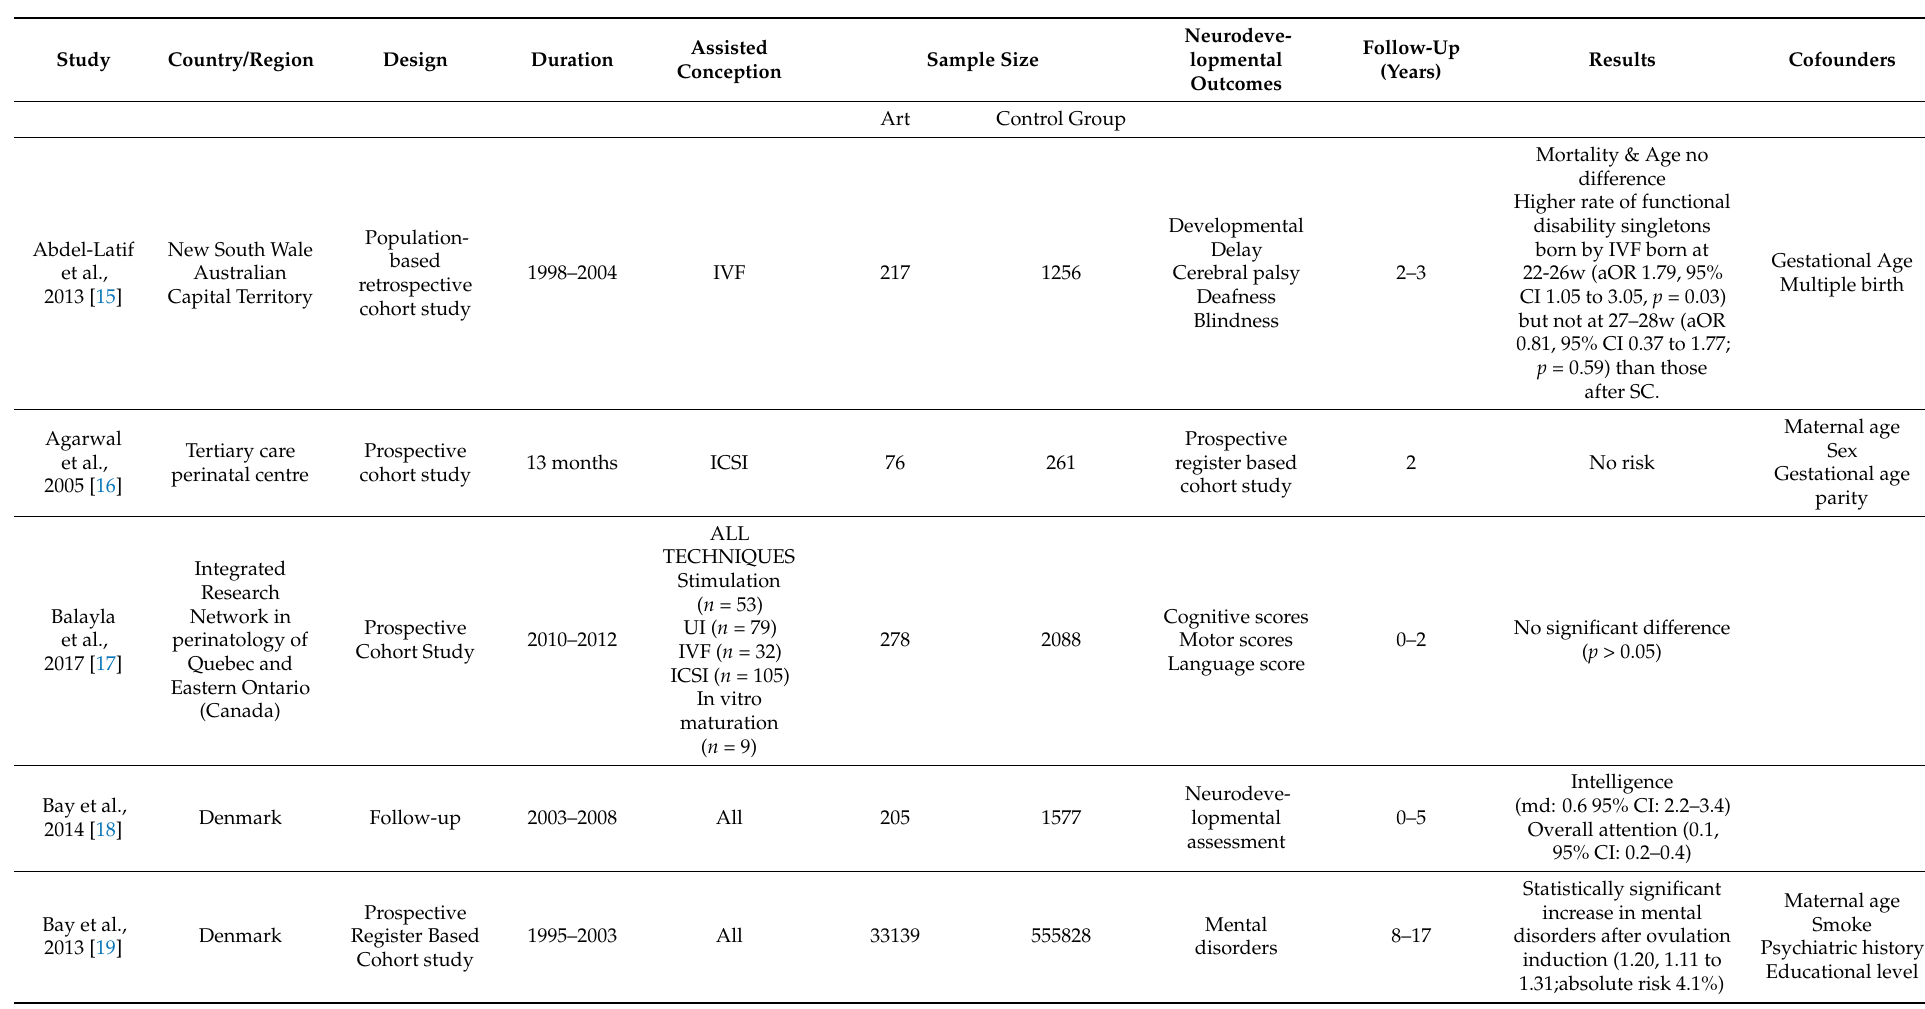
Table 1. Overview of studies on the neurodevelopmental outcomes of infants conceived via assisted reproduction techniques versus naturally conceived